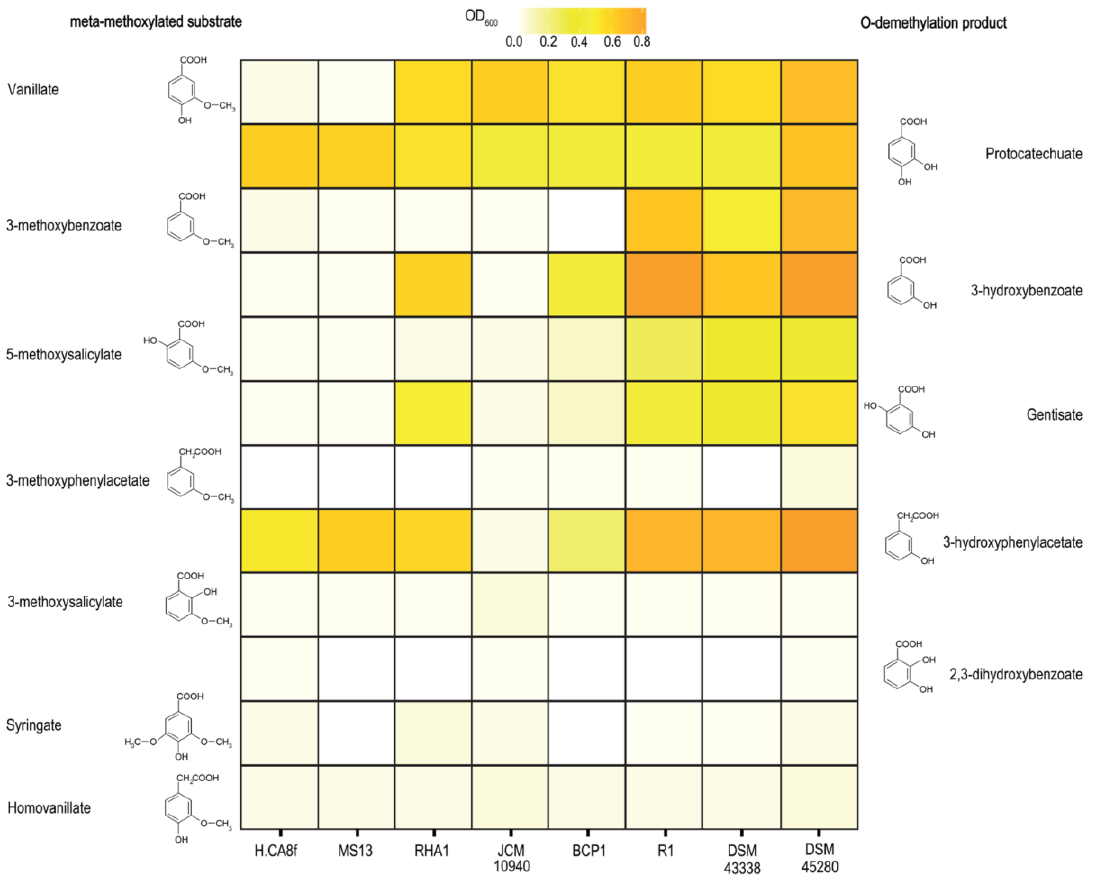
Figure 4. Growth on meta -methoxylated aromatic acids and their O-demethylated products of different Rhodococcus species. Strains belonging to Rhodococcus genus were grown in mineral salt medium with 5 mM of several meta -methoxylated aromatic acids (methoxylated substrates; left side) and its O-demethylated products (right side) as sole carbon and energy sources. Shading indicates optical density (OD) at 600 nm after 40 h (average of three biological replicates). It is worth mentioning that O-demethylated products related to syringate (3-O-methylgallate and gallate) and homovanillate (homoprotocatechuate) were rapidly oxidized in solution yielding an intense dark brown color on the medium, precluding determination of optical density, and consequently were excluded of the